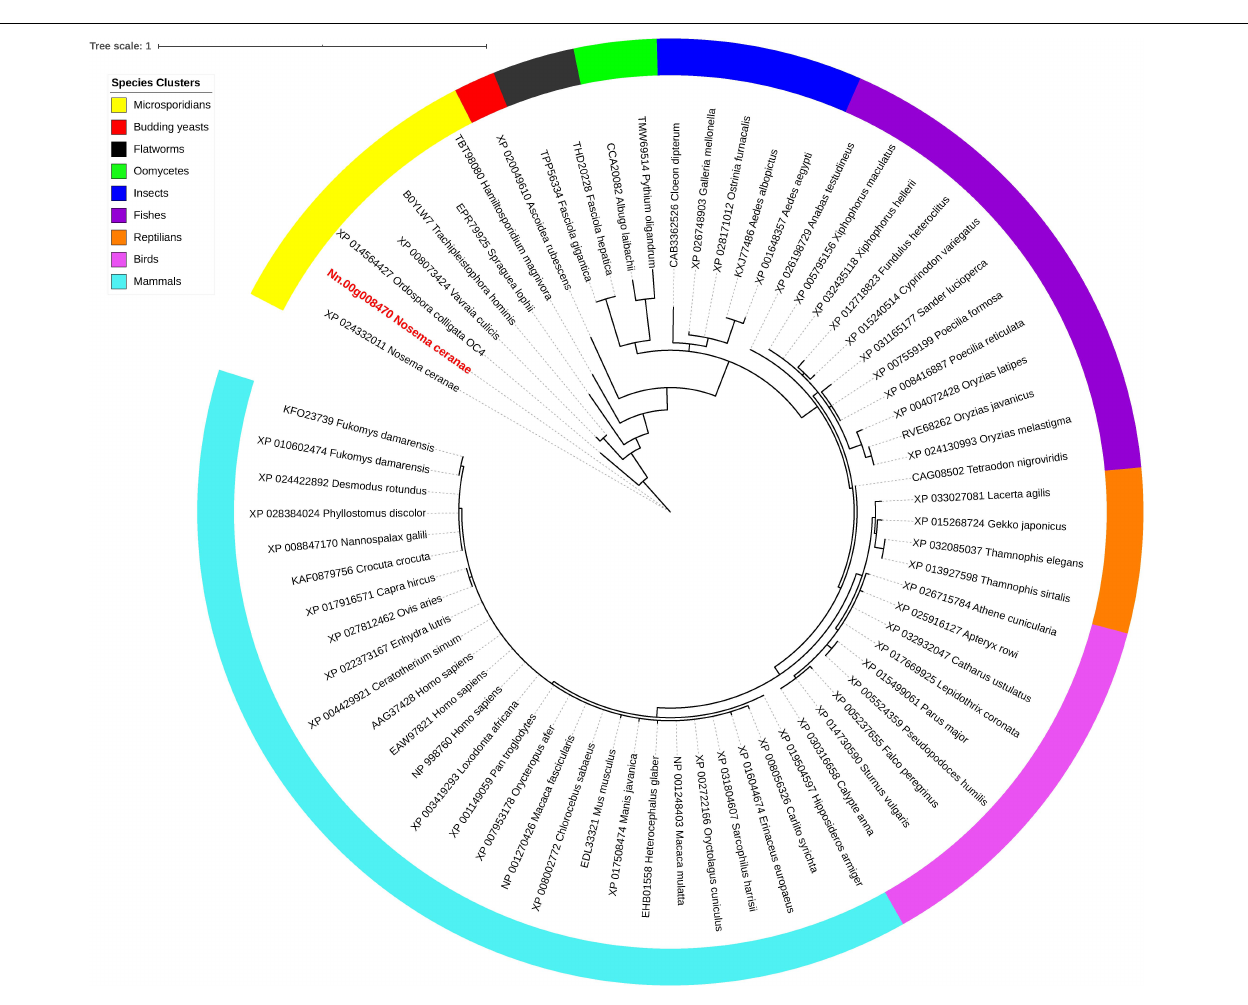
FIGURE 5 | Maximum likelihood phylogenetic tree of Isu1 proteins. Branches are labeled as GenBank accession numbers followed by species names. Branches with bootstrap values (1,000 replicates) less than 0.5 were discarded. The genetic distance is drawn to scale. The current Nosema ceranae record is highlighted with red color. The definitions of the species clusters are adopted from the NCBI Taxonomy